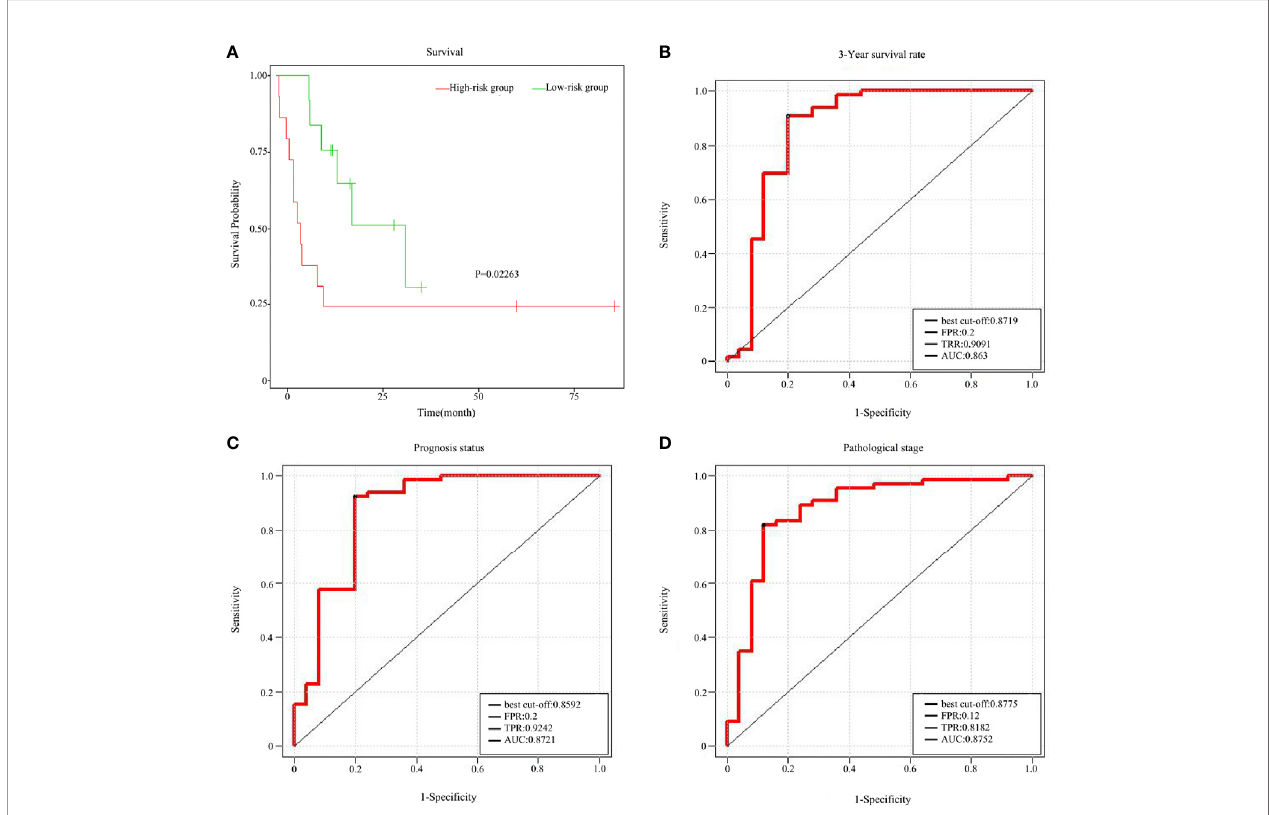
FIGURE 7 | Prognostic value of the survival-associated gene signature in READ. (A) Kaplan – Meier overall survival curves for READ patients classi fi ed into high- and low- risk groups based on the risk score calculated from 10 survival-associated genes. Receiver operating characteristic (ROC) curves displayed the predictive power of the risk Score for the 3-year survival rate (B) , prognosis status (C) , and pathological stage (D) .